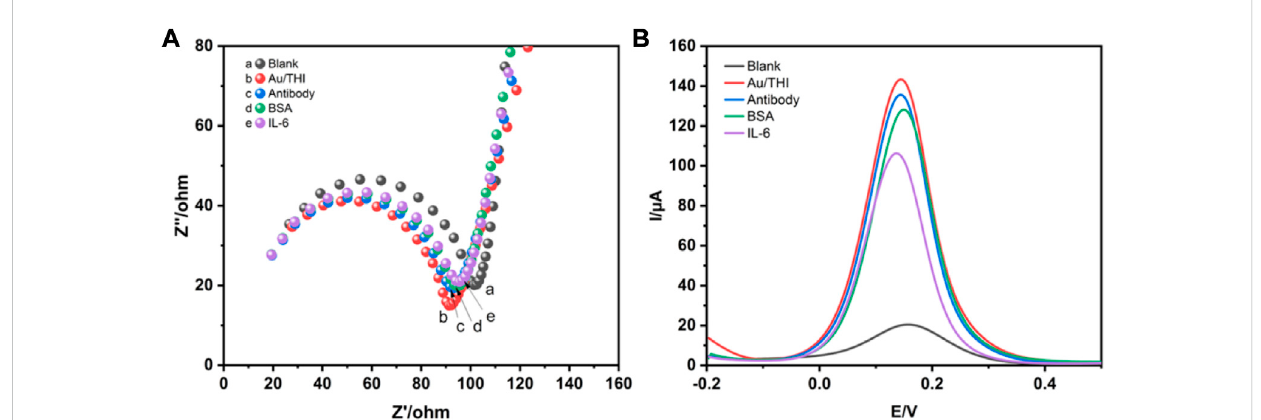
CharacterizationofimmunosensorsforpreparationprocessesbyEISandDPVtechniques. (A) TheNyquistimpedancespectraofblankelectrode(a), AuNPs/THI (b), AuNPs/THI/Antibody (c), AuNPs/THI/Antibody/BSA (d), AuNPs/THI/Antibody/BSA/IL-6 (e). (B) DPV for step-by-step fabrication of the developed electrochemical immunosensors.